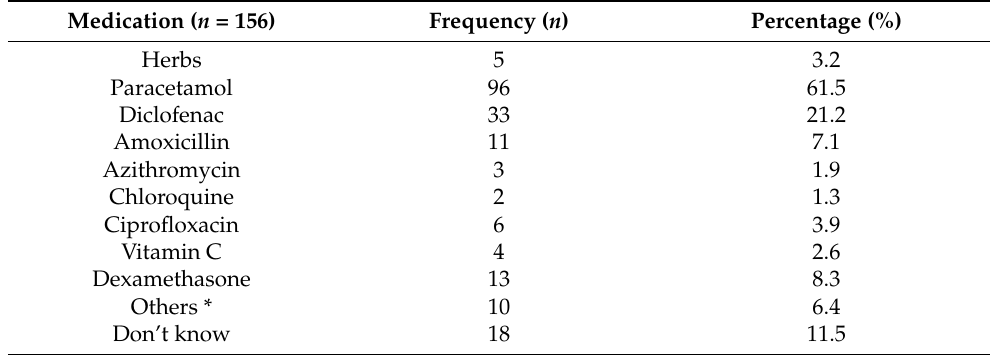
Table 3. Medications following Oxford/AstraZeneca vaccine side-effects.